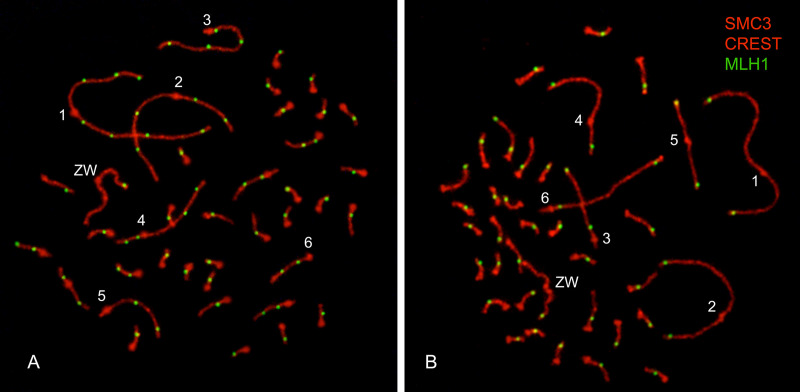
Immunolocalization of recombination events in chicken and guinea fowl oocytes.Chicken (A) and guinea fowl (B) immunostained oocytes showing the complete sets of synaptonemal complexes. The number of bivalents, including the sex pair, is 39 in the chicken and 38 in the guinea fowl. The six largest synaptonemal complexes are labeled with a number next to the centromere signal (red bulging dots). In the guinea fowl, foci on macro-SCs are predominantly located towards the chromosome ends.